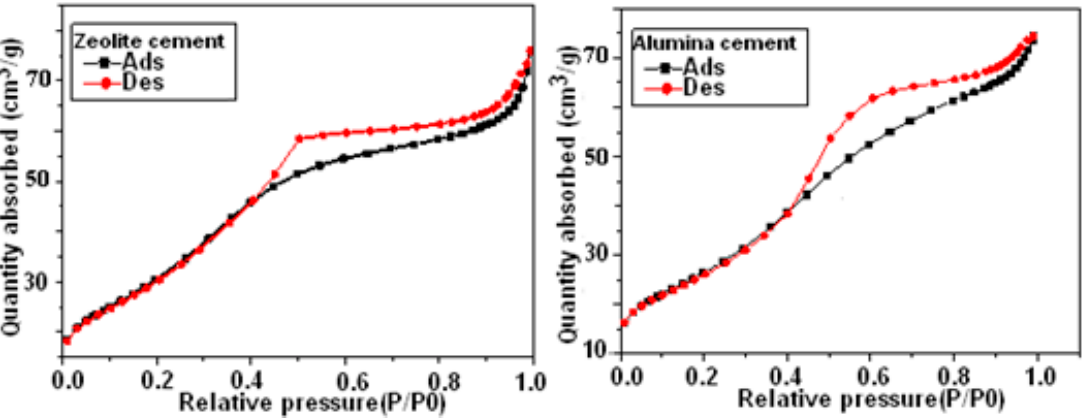
Figure 7. N2 ‐ adsorption/desorption curve for zeolite and alumina cements. Figure 7. N2-adsorption/desorption curve for zeolite and alumina cements.